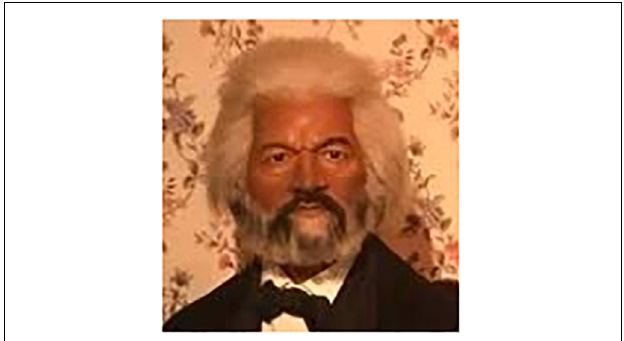
FIGURE 1 | Likeness of Frederick Douglass. Wax figure representation in Washington, DC in 2020.